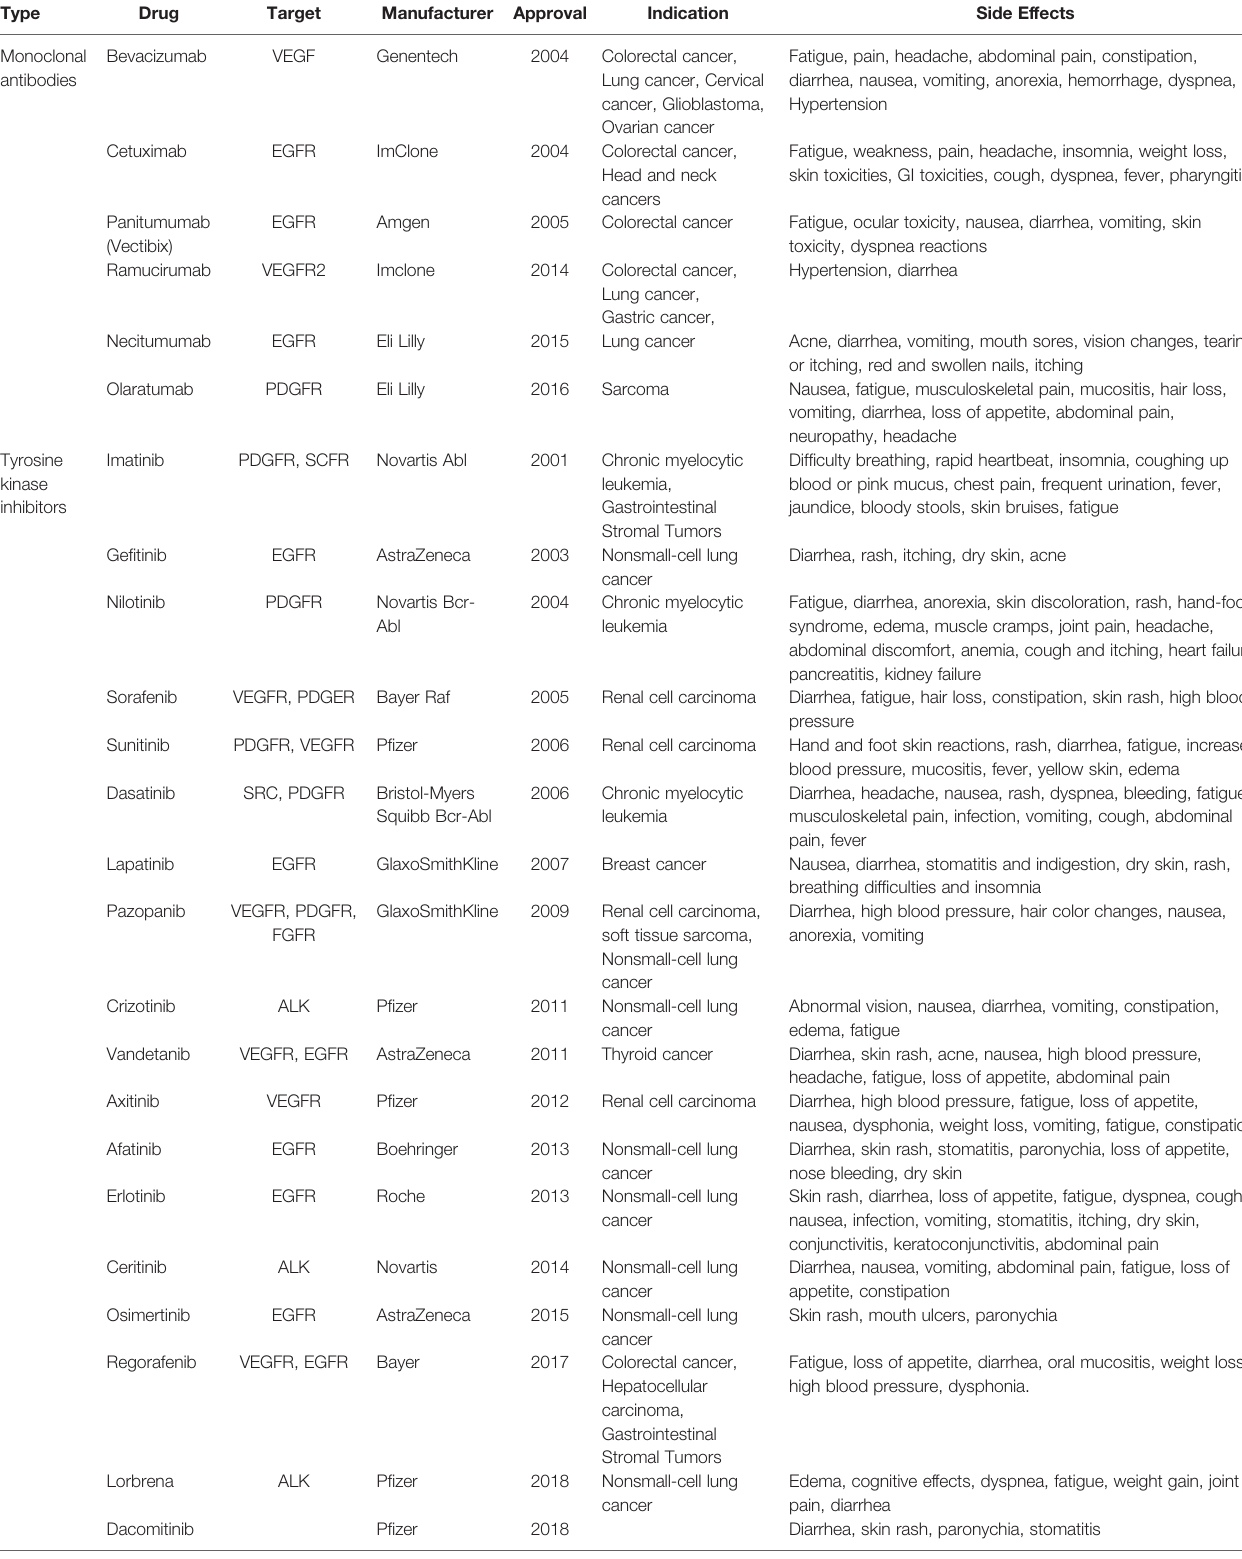
TABLE 1 | Anti-angiogenic drugs.